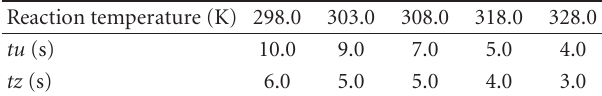
Table 1: The induction time ( tu ) and the oscillation period ( tz ) at various reaction